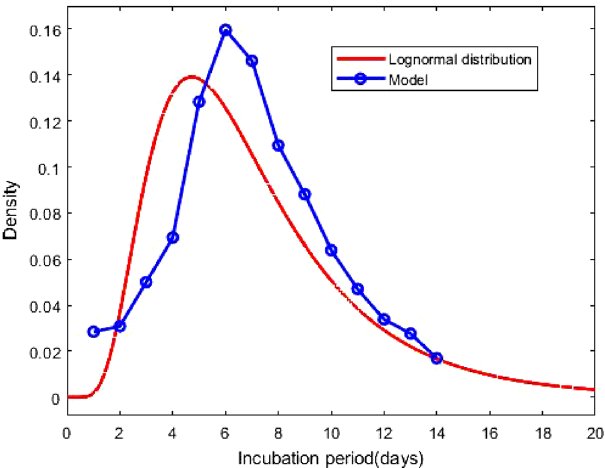
Figure 5. Probability density function of the lognormal distribution of the incubation period with µ = 1.83 and σ = 0.53 . The result based on the confirmed corona cases of a particular day, October 23, 2020. The blue circles indicate the densities obtained from the model calculation.